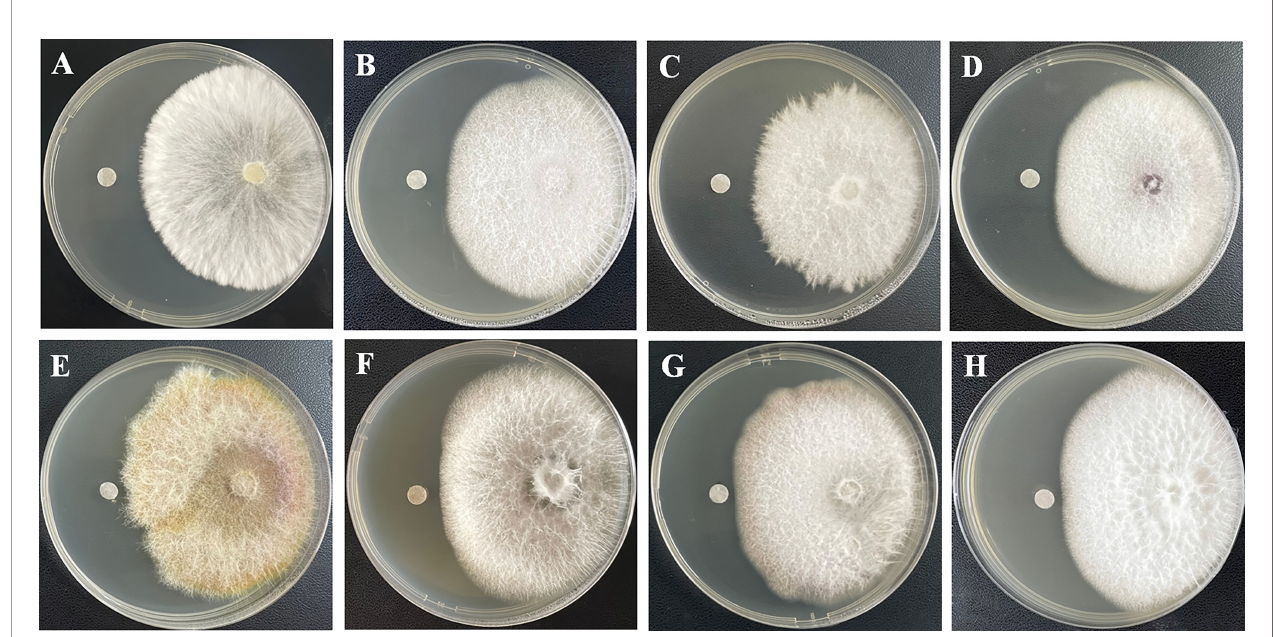
FIGURE 5 | Antifungal activities of 1 against eight plant pathogenetic fungi − S. rolfsii (A) , F. oxysporum (B) , C. diplodiella (C) , P. piricola (D) , F. graminearum (E) , A. mali (F) , C. orbiculare (G) , and A. porri (H)